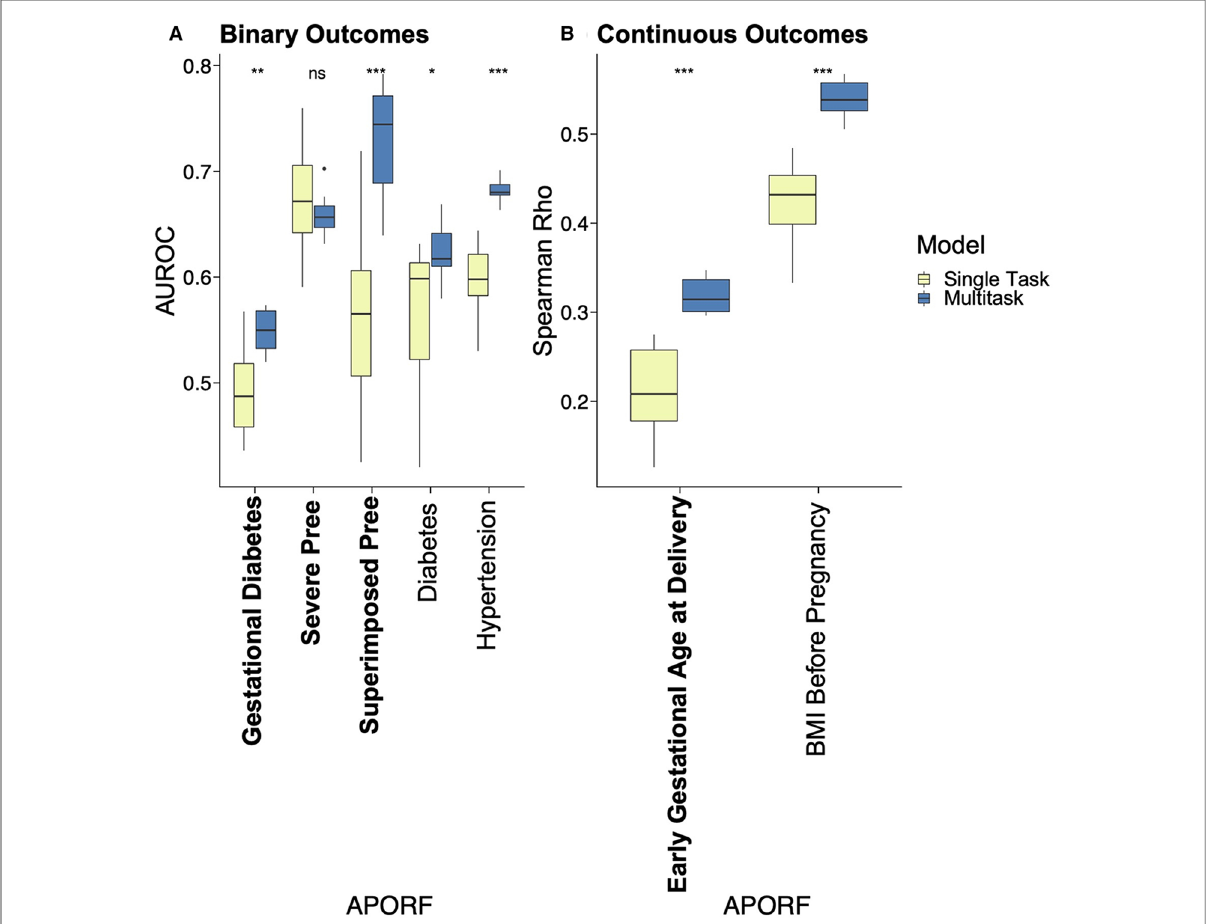
FIGURE 3 Performance comparison of single task vs. MML for predictive models of APOs. APOs are bolded, and pathophysiological RFs are unbolded. Results of multitask models are blue, and single task models are yellow. Asterisks represent signi fi cant differences by the Wilcoxon test between single task and multitask approaches (ns: p >0.05, * p <=0.05, ** p <=0.01, *** p <=0.001, and **** p <=0.0001). “ Pree ” is an abbreviation for preeclampsia. With one exception where no signi fi cant prediction differences are recorded, multitask models signi fi cantly outperformed single task models in all cases, emphasizing the interrelatedness between APORFs and successful joint